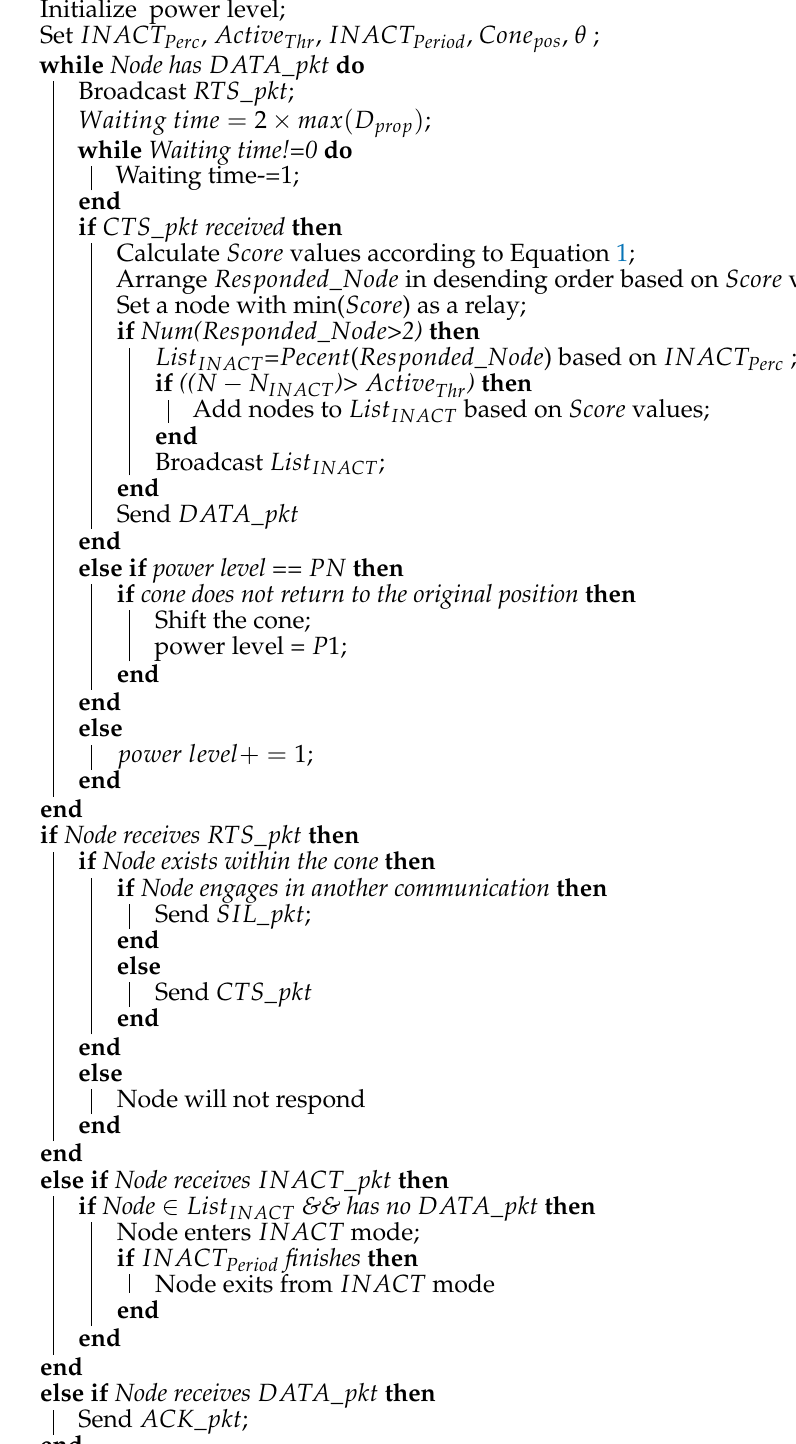
Algorithm 1: Pseudocode for the proposed EE-UWSNs